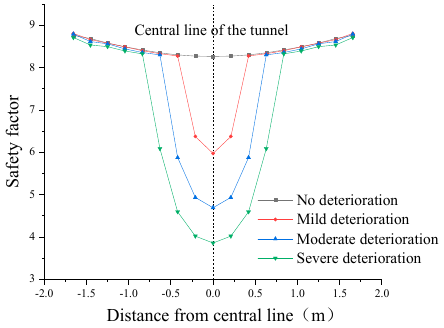
Figure 18. Safety factor of degraded lining.